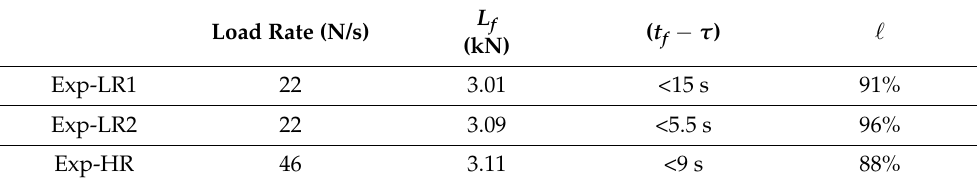
Table 3. The details of the Ib -values when the Ib -value < 1.5 for the presented